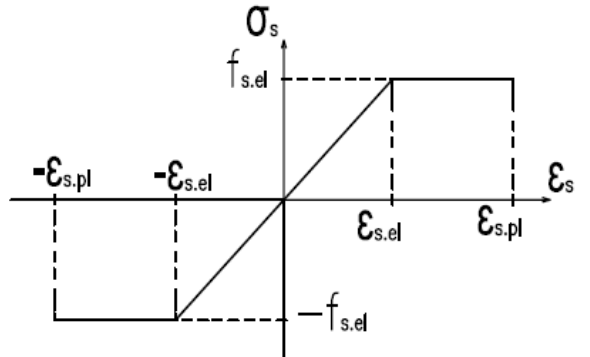
Figure 5. Stress–strain diagram for steel.